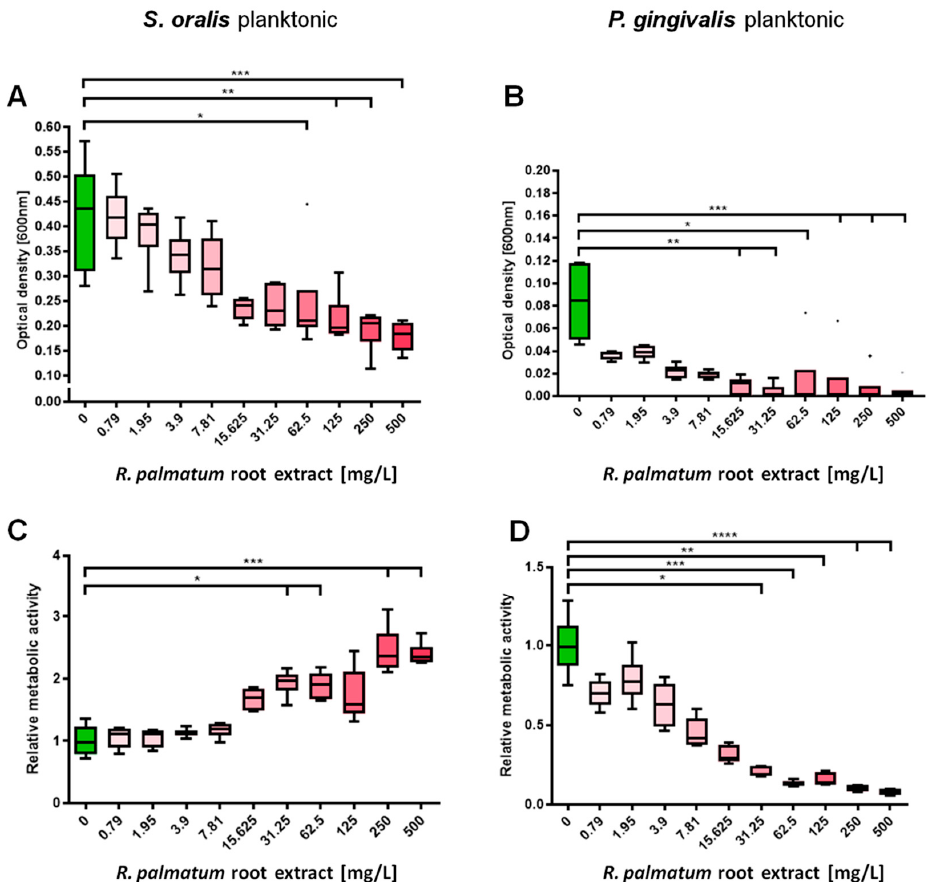
Figure 1. Effects of R. palmatum root extract on planktonic S. oralis and P. gingivalis . After 24 h of incubation. planktonic growth of P. gingivalis was significantly inhibited by lower concentrations of R. palmatum root extract than the growth of S. oralis was. ( A ) Treatment with 62.5 mg/L R. palmatum root extract or more resulted in significant reductions in the optical density of S. oralis . ( B ) Treatment with 15.625 mg/L R. palmatum root extract or more resulted in a significant reduction in the optical density of P. gingivalis . ( C ) Treatment with 31.25 mg/L R. palmatum root extract or more resulted in a significant increase in the relative metabolic activity of S. oralis . ( D ) Treatment with 31.25 mg/L R. palmatum root extract or more resulted in a significant reduction in the relative metabolic activity of P. gingivalis . Kruskal–Wallis test with Dunn’s correction for multiple comparisons, N = 6 with S.